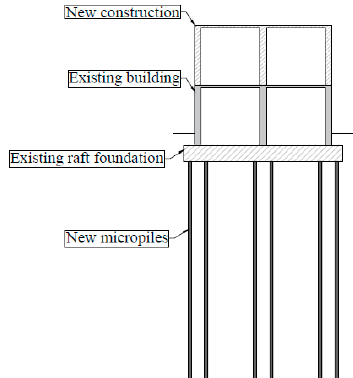
Figure 1. MPs used for increasing foundation capacity of an existing building (after [3]).